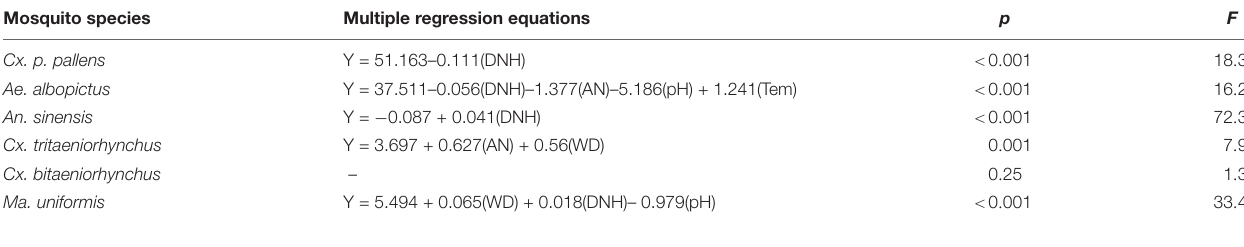
TABLE 5 | The multiple regression equation shows the contribution rate of each variable to mosquito density.